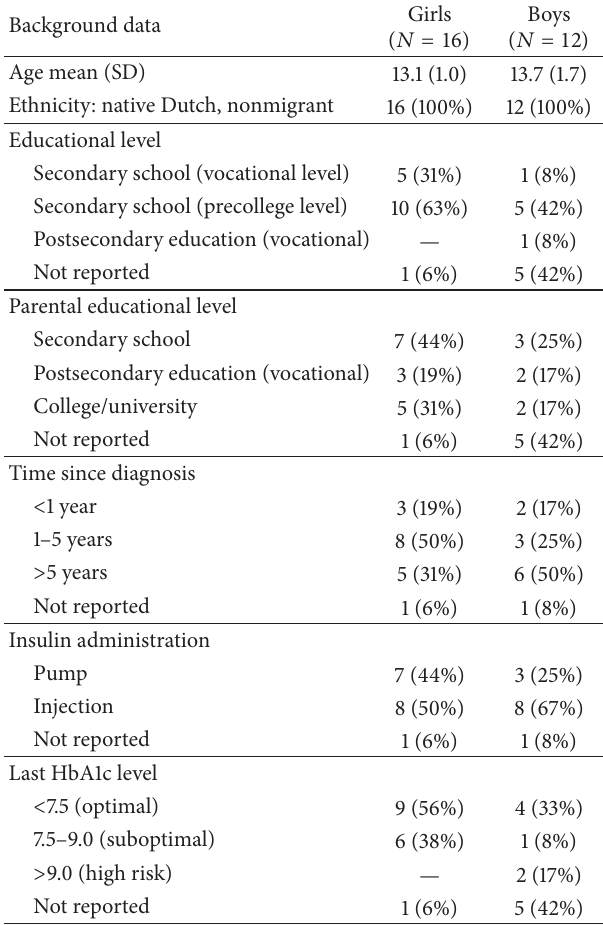
Table 1: Background characteristics of adolescents with diabetes in study